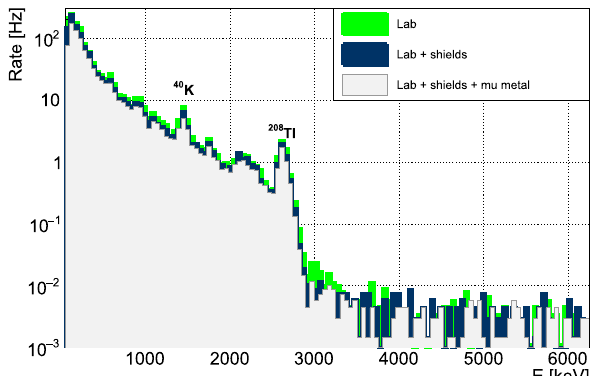
Fig. 5 Energy spectrum of the γ -ray flux measured using a 3” portable NaI spectrometer. Green: original spectrum collected in a laboratory of cryogenic detectors (Italy). Blue: same spectrum inside the cryostat thermal and vacuum vessels. Gray: same spectrum as (blue) but adding also the mu-metal magnetic shield